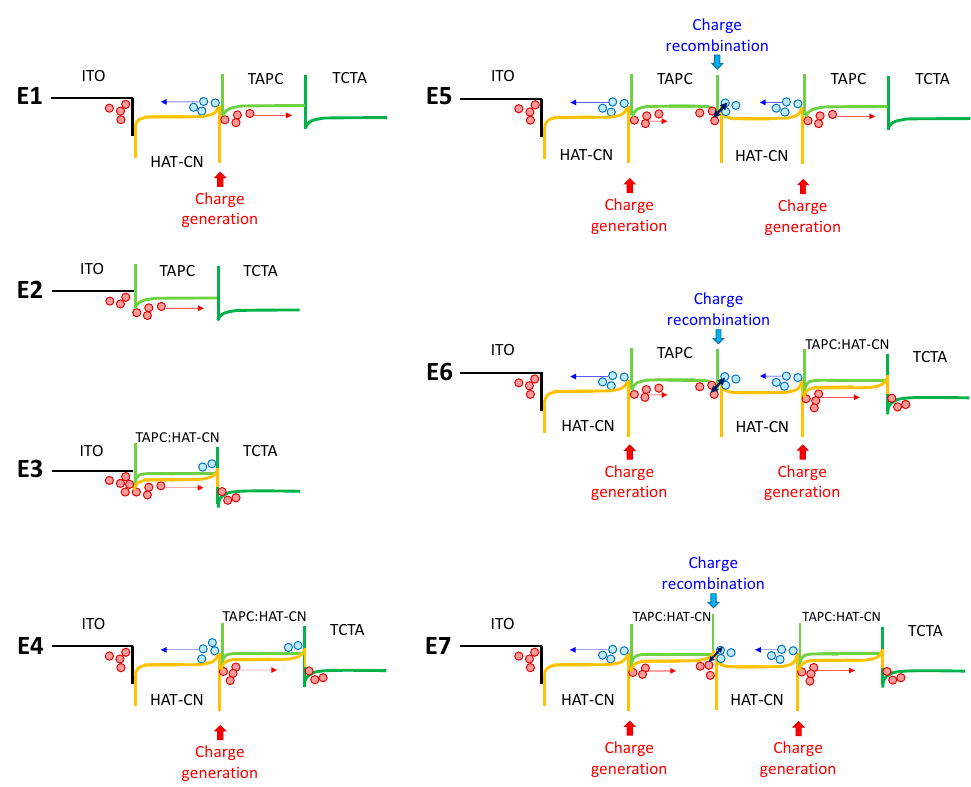
Figure 6. Schematic energy level diagram of the HIL structures of devices E1–E7 under bias.